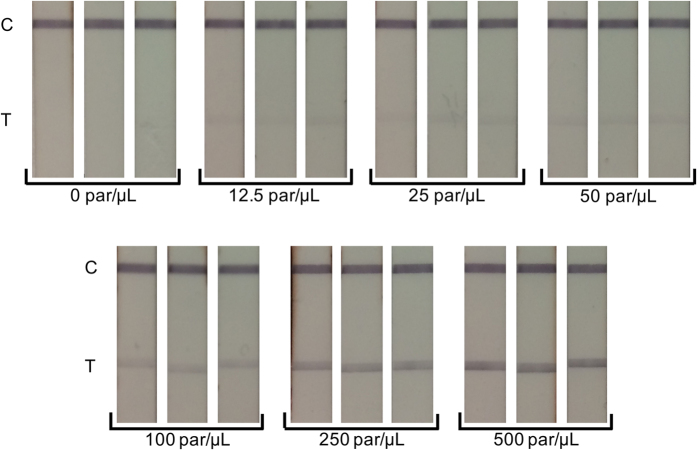
RDT images at concentrations of 0, 12.5, 25, 50, 100, 250, and 500 parasites per microliter of blood.The control lines and test lines of the RDTs are identified by C and T, respectively. These images have been manually cropped, re-sized, and aligned for uniformity, but not contrast enhanced or brightened.